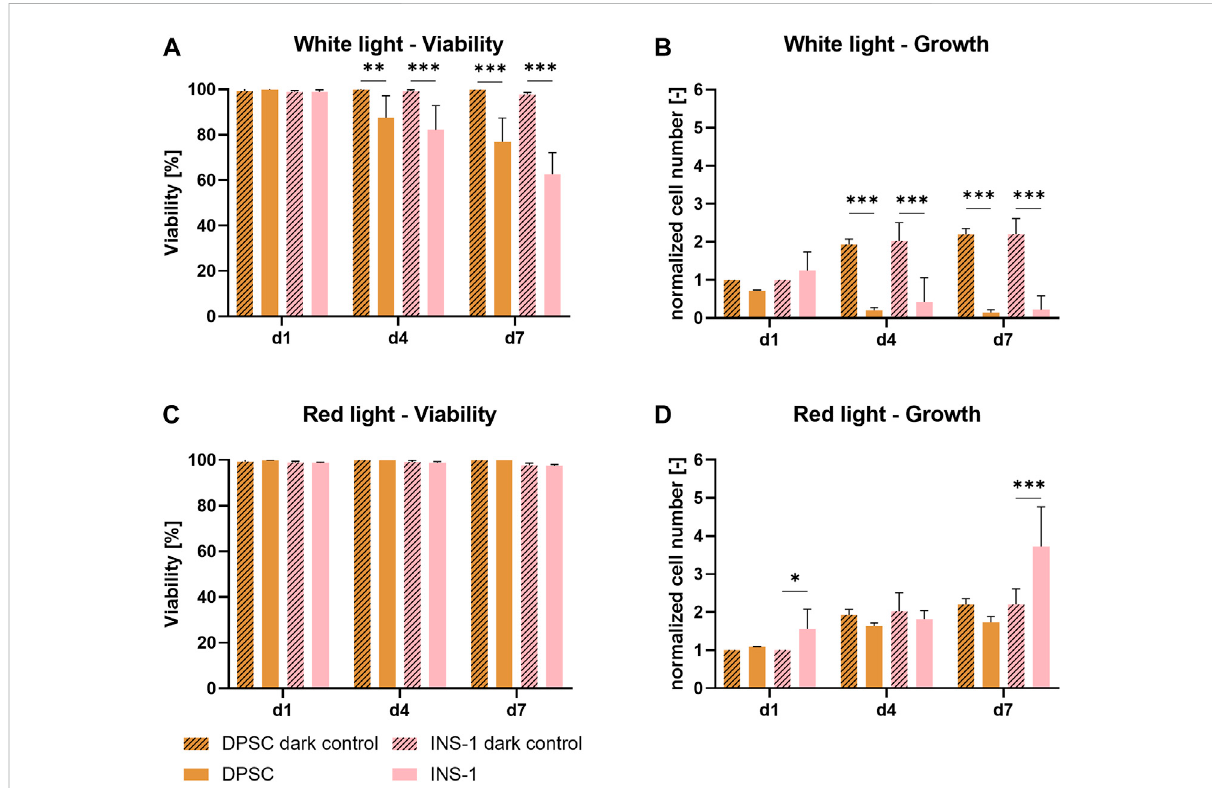
FIGURE 1 Viability (A,C) and growth (B,D) of DPSC and INS-1 monolayer cultures, cultivated over 7 days with white- or red-light illumination; usual cultivationinthedark wasconducted as control.Thecell numbers (B,D) werenormalizedto thecell numberoftherespective darkcontrolgroup on day one. Depicted are mean ± standard deviation, n ≥ 12 (A,C) , n ≥ 3 (B,D) ; * p < 0.05; *** p < 0.001.